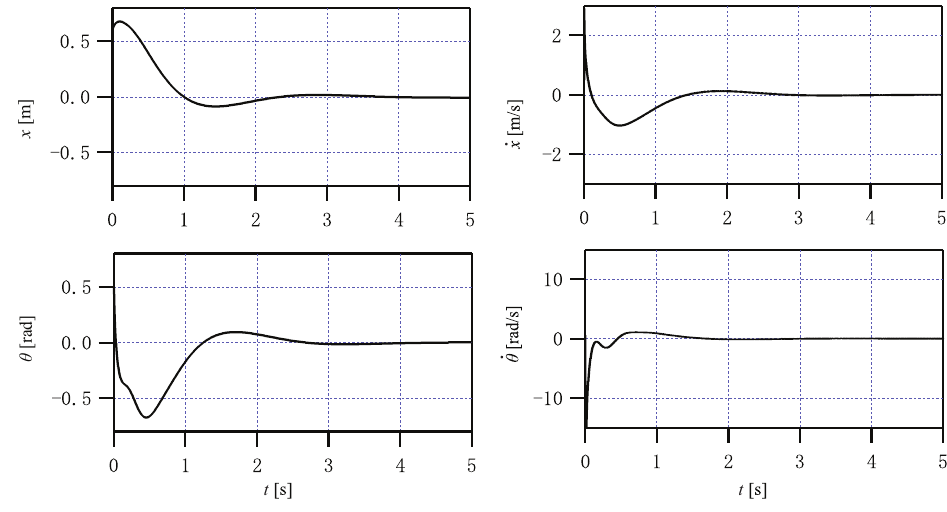
Figure 3. Time responses of the TORA system by the robust controller (29) with (34) and (37).